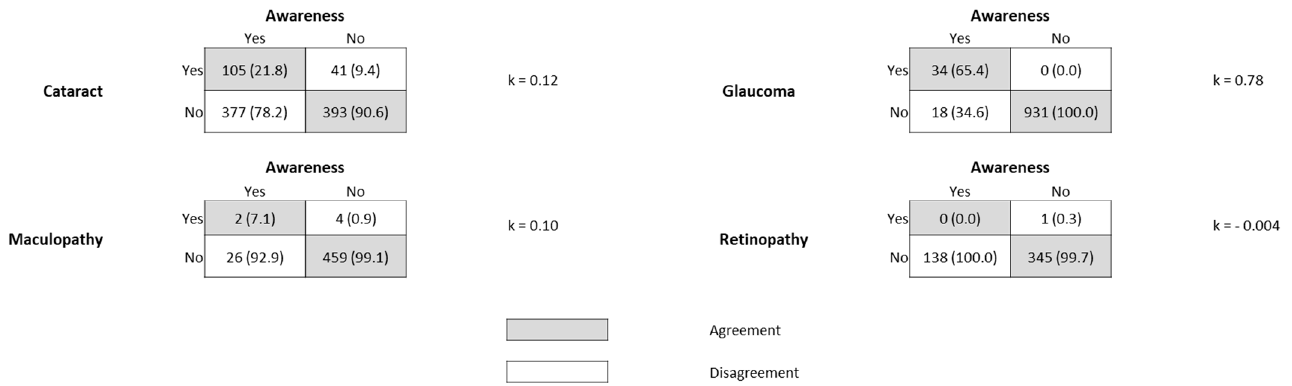
Figure 2. People aware about their eye disease. Rows indicate the presence/absence of eye disease whilst the columns indicate the awareness of participants about the disease.